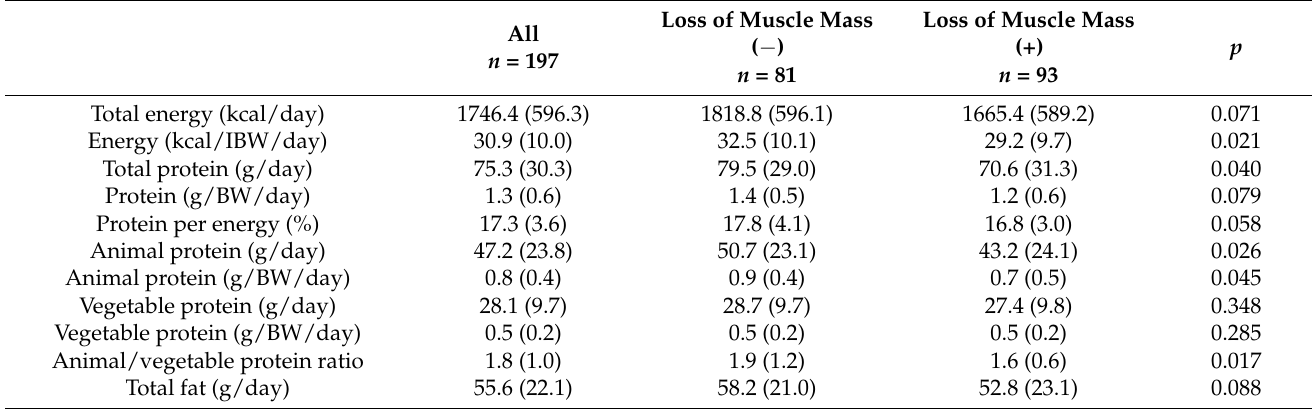
Table 2. Habitual dietary intake at baseline of study